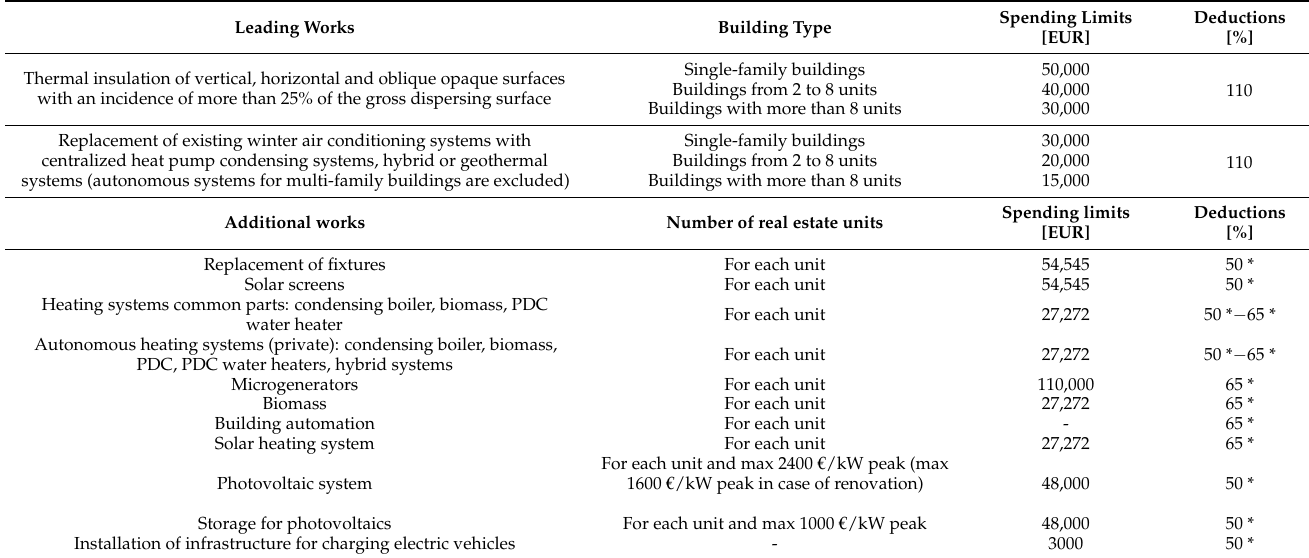
Table 1. Summary of the interventions admitted to the Superbonus, the related spending limits, and the deductible percentages (parameters relating to the 2020–2022